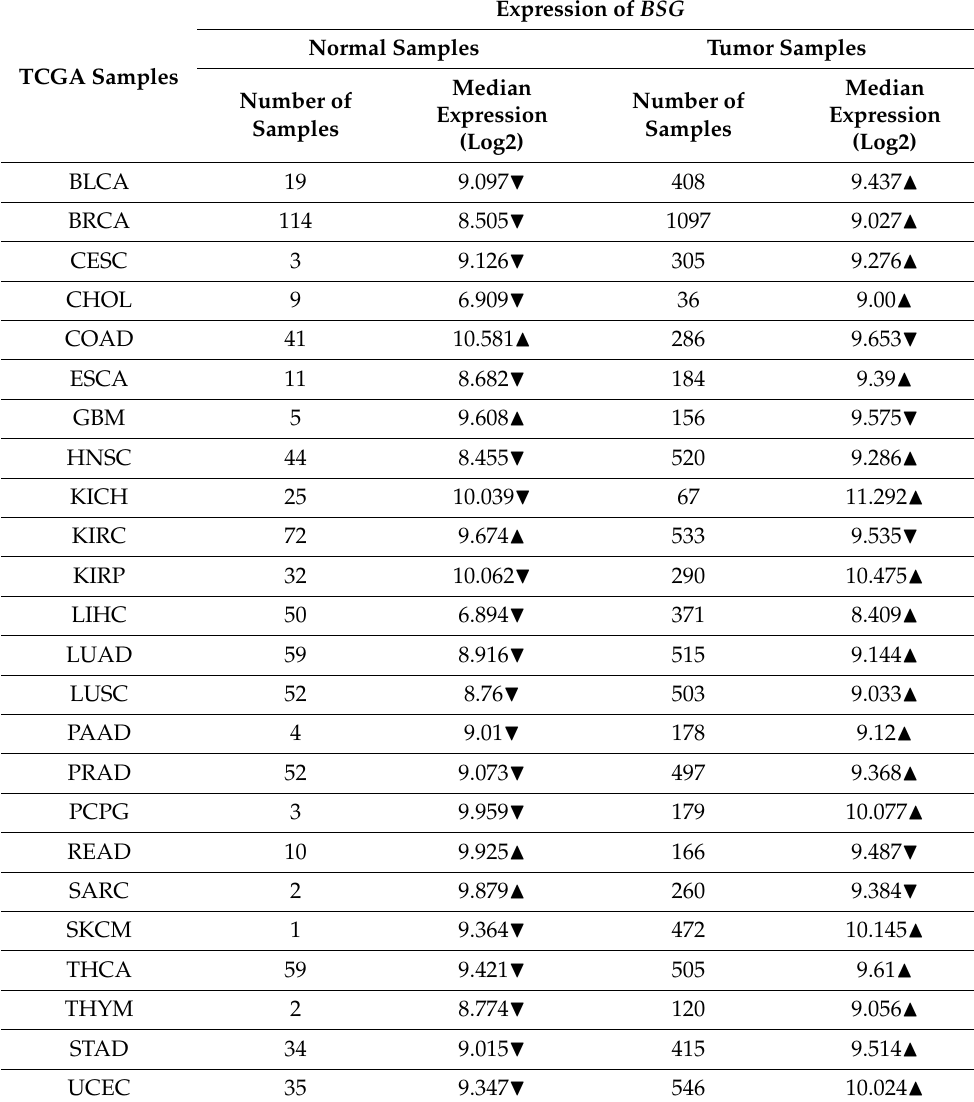
Table 4. The mRNA expression levels of BSG in normal and tumor